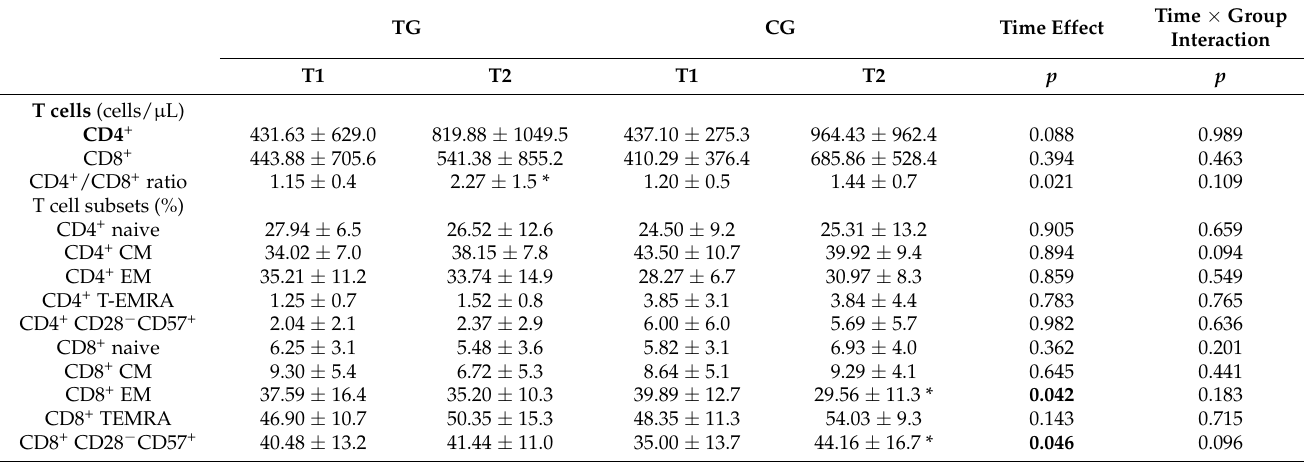
Table 3. CD4 + and CD8 + cells and their subpopulations at time point 1 (T1) and T2 in training group (TG) and control group (CG) (mean ± SD) among a subgroup of n = 16 participants.